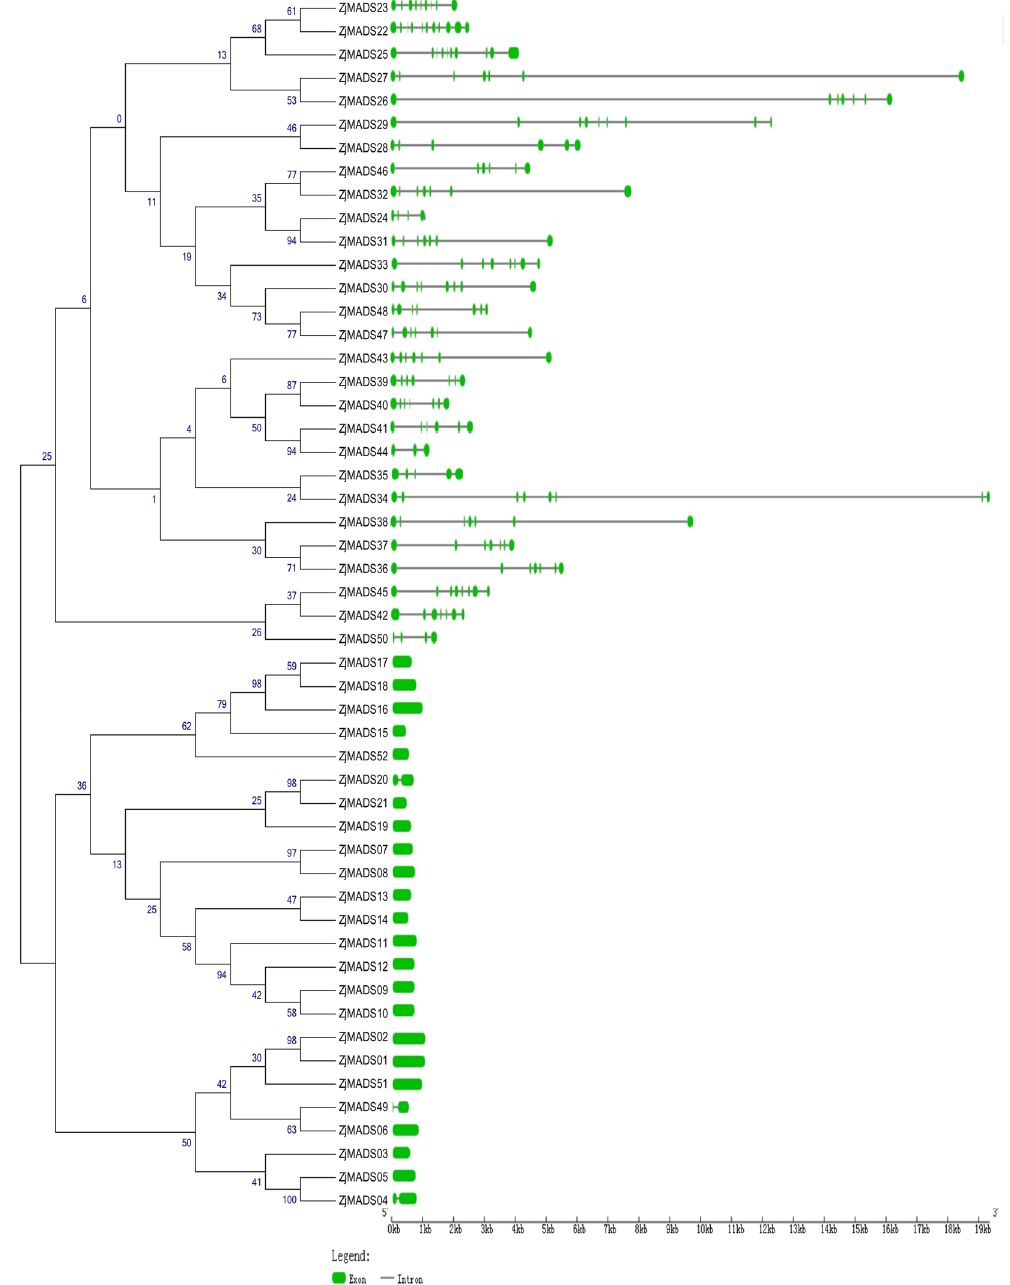
Figure 3. Phylogenetic relationships and structural analysis of MADS-box genes in the Chinese jujube. The unrooted neighbor-joining tree was constructed from the alignment of full-length amino acid sequences. Lengths of exons and introns of each MADS-box gene are displayed proportionally. Green solid boxes represent exons; black lines represent